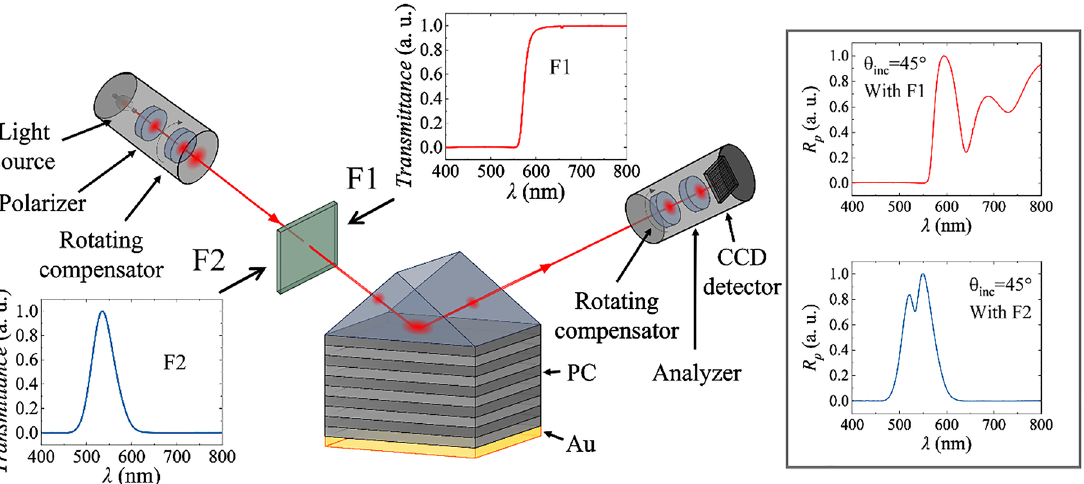
Figure 1: Experimental setup scheme used for strong coupling measurements. The ellipsometer consisted of the Xe lamp (Xe), polarizer (P), rotating compensator (RC), analyzer (A), and the CCD detector (CCD). Filters (the transmittance of thesefiltersaremarkedas F1 (redline)andF2(blueline)wereplacedbeforethelightreachedtheprism.After reflectionfrom the sample, the optical response of the hybrid TPP-SPP mode is shown in graphs on the right side (top) h-SPP and h-TPP (bottom).